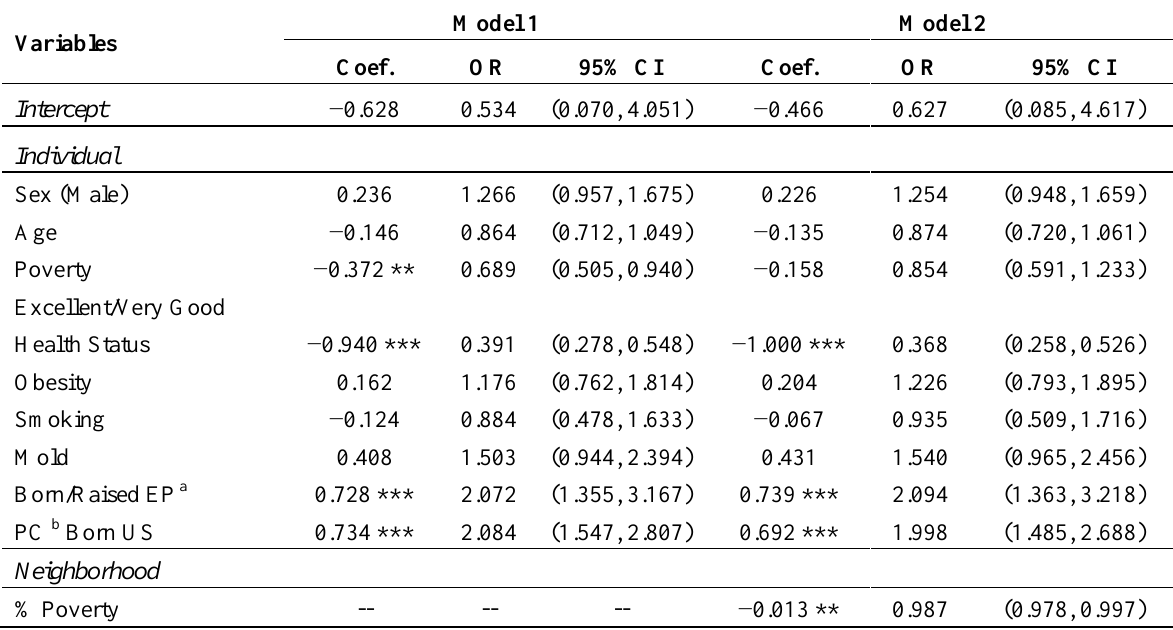
Table 3. Individual and neighborhood characteristics associated with children’s current